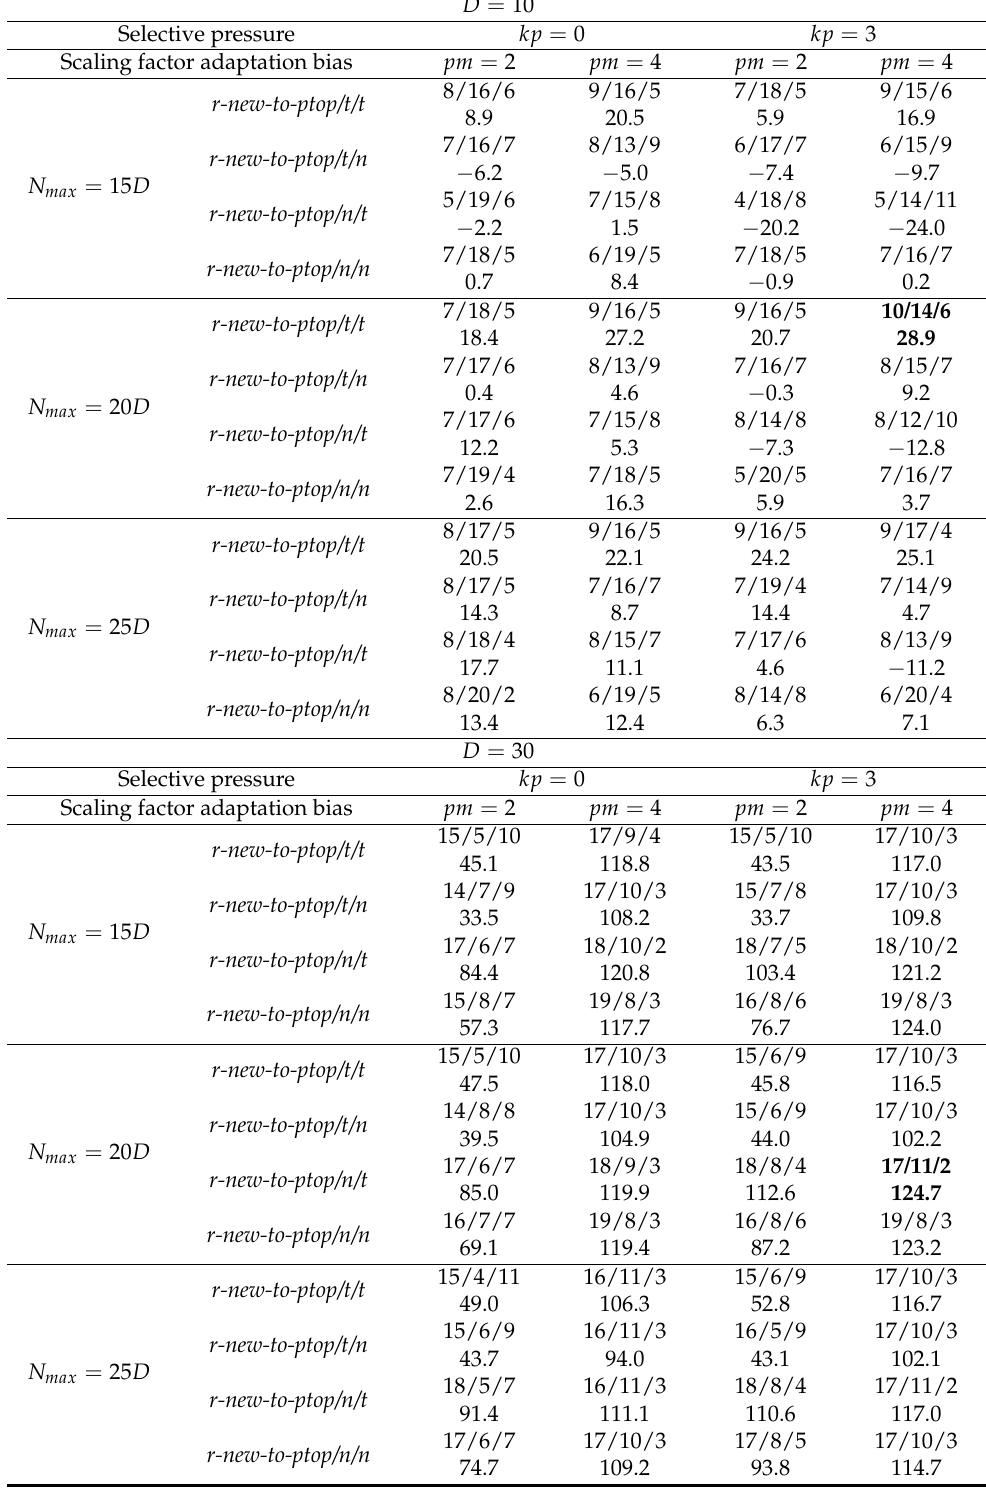
Table 2. L-NTADE vs. L-SHADE-RSP, CEC 2017, 10 D and 30 D , Mann–Whitney tests and total standard